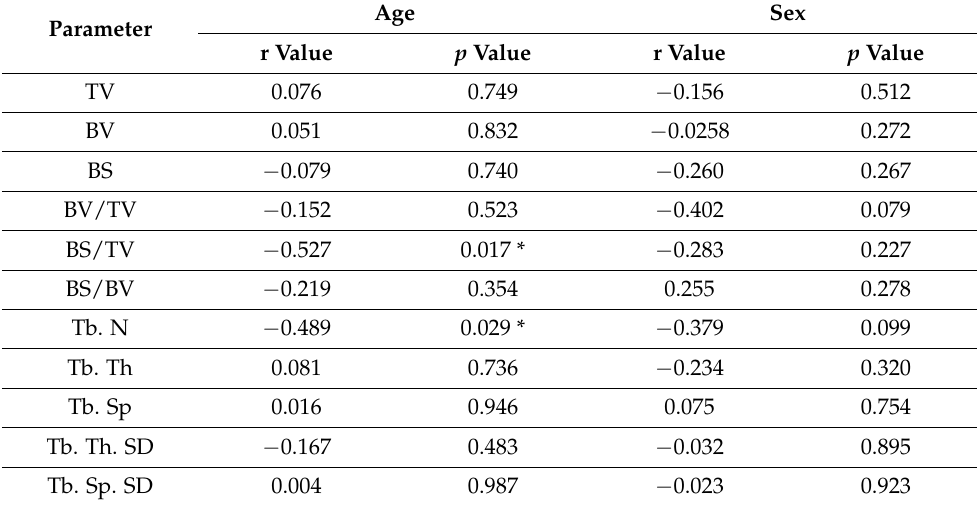
Table 4. The correlation between age and sex with the TBM